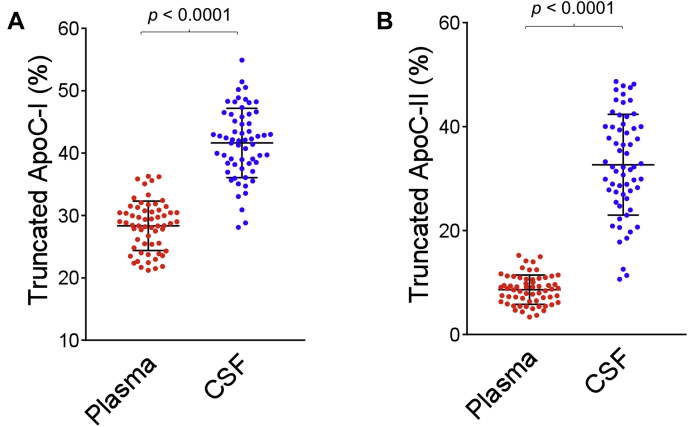
Percent abundance of (A) truncated apoC-I and (B) truncated apoC-II in plasma versus CSF. Percent truncation was computed by dividing the peak area of each truncated isoform with the summed peak areas of the truncated and full-length protein. Parametric paired t-tests were performed to identify differences between plasma and CSF samples between the normally distributed data sets.